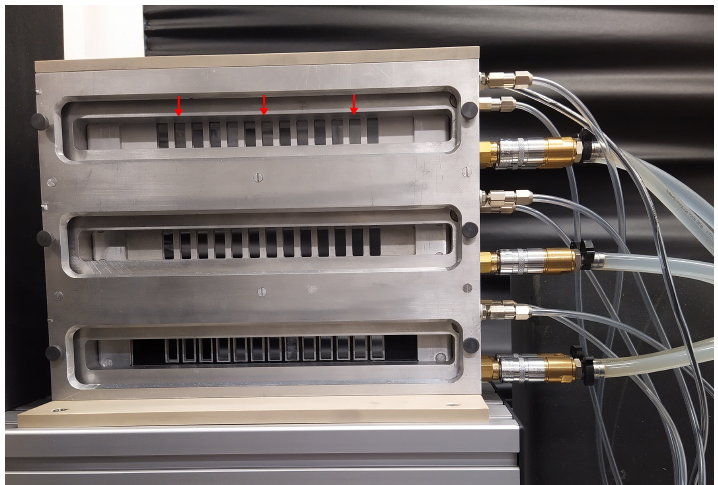
Figure 1. Photograph of the sample changer. The sample changer consists of a rack for 3 magazines each holding up to 13 cuvettes. Each magazine’s temperature can be controlled individually. The open sides can be flushed with dried air to prevent condensation, when measuring at low temperatures. This part of the setup can also be used for standard SANS experiments without DLS. The red arrows indicate the cuvette positions, that were used for the temperature measurements in Figure 2.